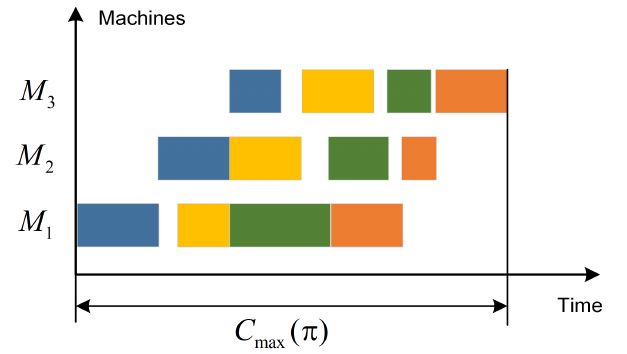
Figure 1. A Gantt chart of a no-wait flow